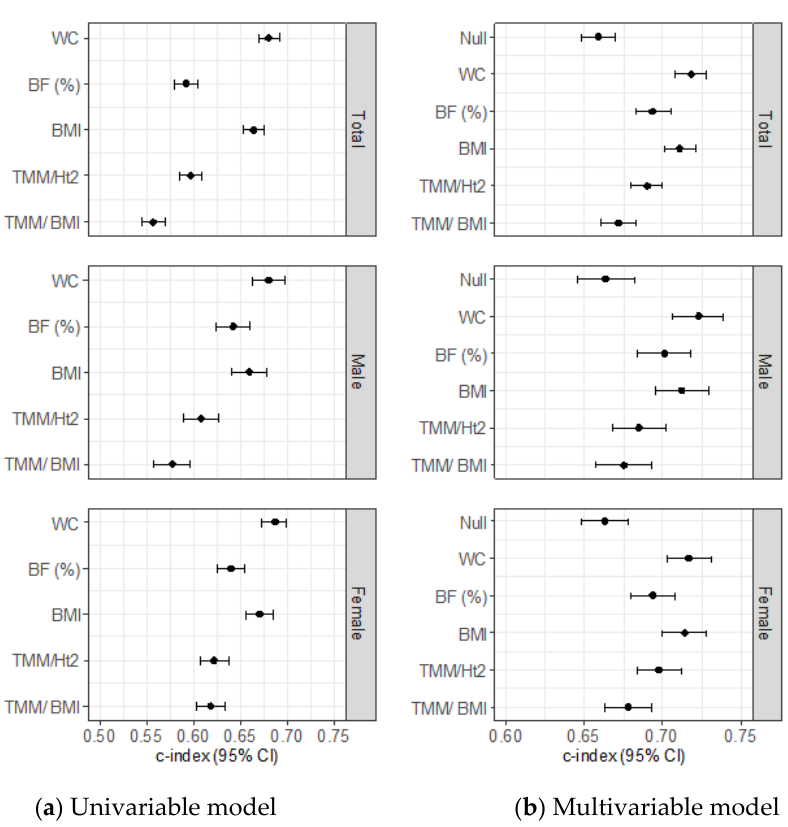
Figure 2. Harrell’s concordance index and 95% Confidence intervals for predicting NAFLD incidence of five different body composition indices. ( a ) Unadjusted model in total population, men and women, ( b ) Adjusted for age, sex (in total), smoking status, alcohol drinking status, physical activity, total calorie intake, mean blood pressure, fasting plasma glucose, CRP, and alanine aminotransferase in total participants, men and women. Abbreviation: BF, Body fat; BMI, Body mass index; CRP, C-reactive protein; TMM/Ht 2 ; Total muscle mass divided by squared of height; TMM/BMI, Total muscle mass divided by body mass index